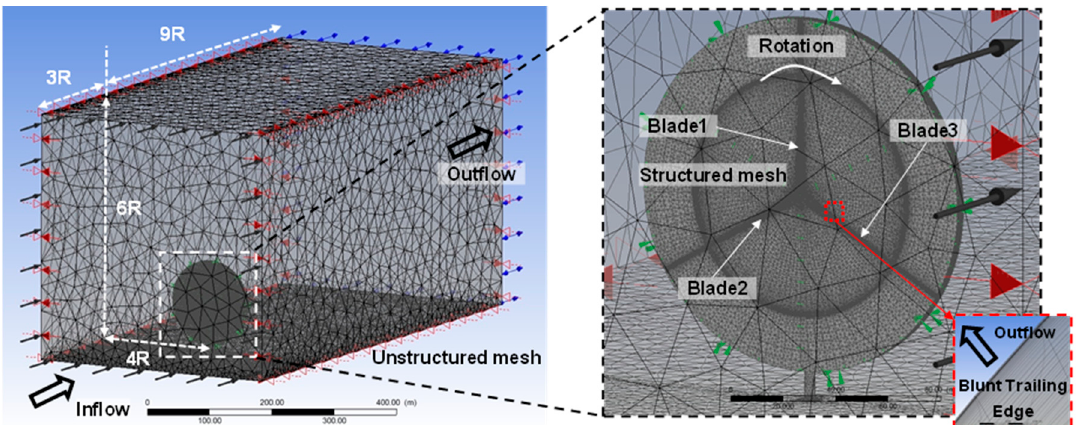
Figure 3. Whole computational domain for computational fluid dynamics (CFD) analysis.